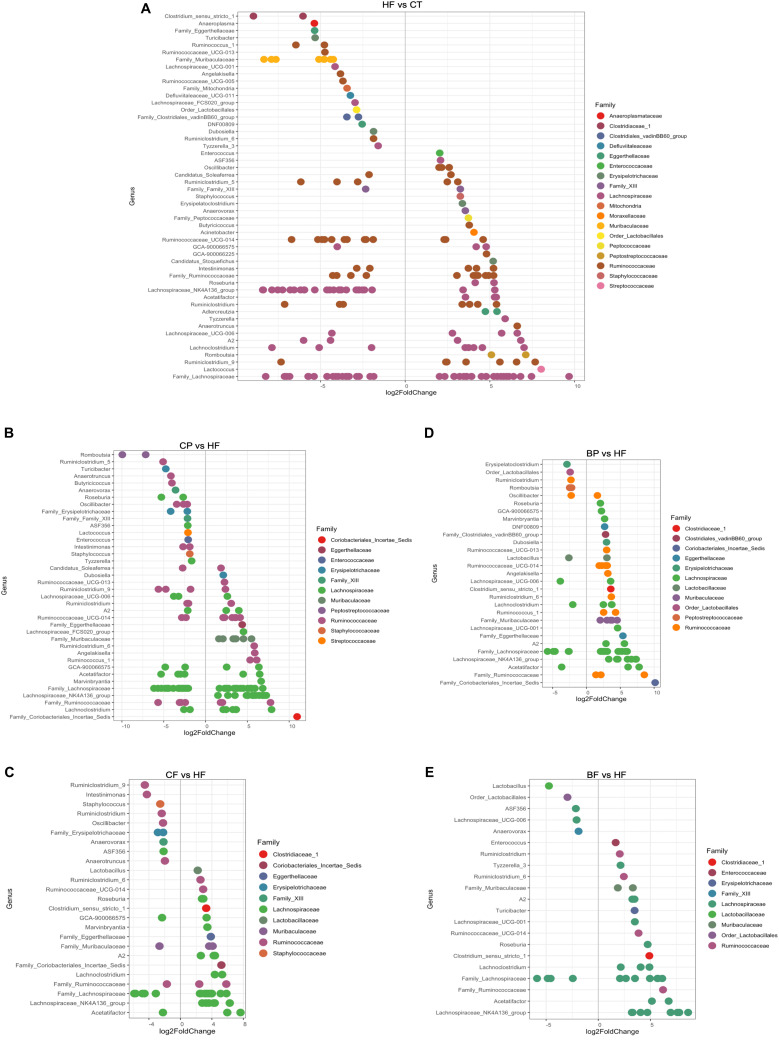
Taxa significantly up-regulated and down-regulated by polyphenol-rich CP and BP and their fiber-rich CF and BF. (A) Differential abundance analysis (DESeq2) identified 51 ASVs significantly modulated in mice fed HFHS (HF) relative to lean mice fed Chow (CT); (B) 38 ASVs were modulated in mice fed polyphenol-rich whole cranberry powder (CP) relative to HFHS; (C) 25 ASVs were modulated in mice fed cranberry fibe-rich fraction (CF) relative to HFHS; (D) 29 ASVs were modulated in mice fed polyphenol-rich whole blueberry powder (BP) relative to HFHS; (E) 21 ASVs were modulated in mice fed blueberry fiber-rich fraction (BF) relative to HFHS. ASVs (p < 0.05, FDR-corrected) are represented by single data points (with some data points overlapping) within each genus grouped on the x-axis, and by color fitting to which taxonomic family the ASVs belong. Data are plotted as log2 fold change (n = 12 mice per group). ASVs to the right of the zero line are more abundant and ASVs to the left of the zero line are less abundant.